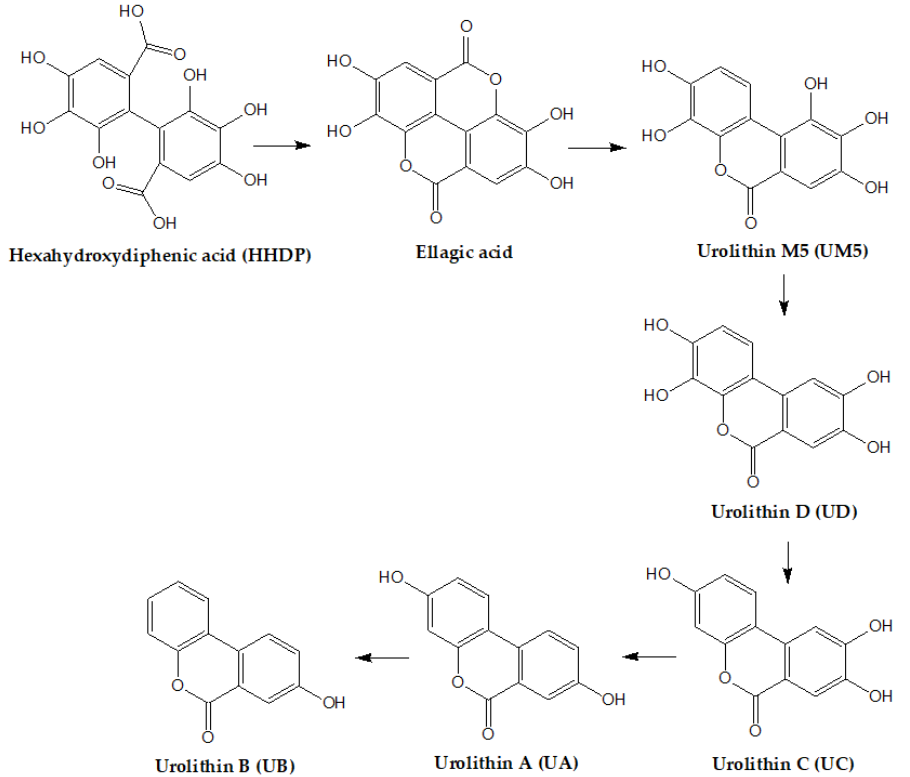
Figure 2. Ellagic acid and some of its microbial metabolites, the